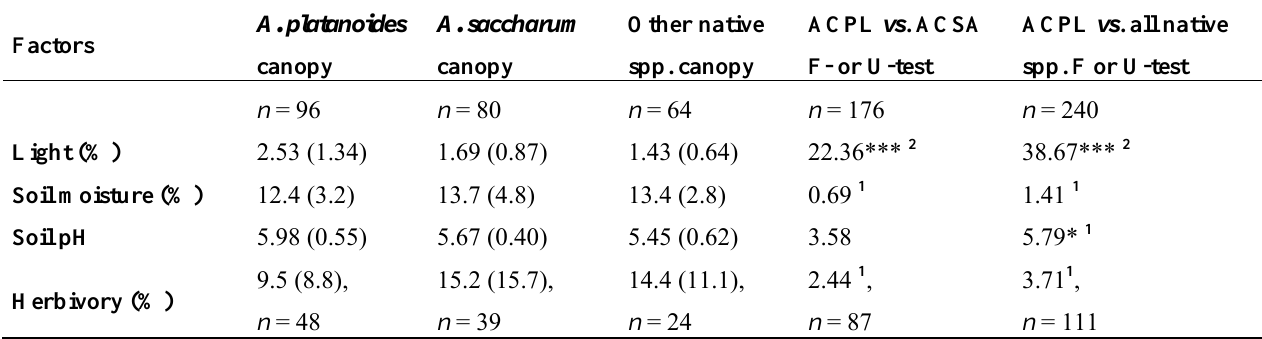
Table 3. Ecological factors measured under A. platanoides , A. saccharum and other native species canopies. Mean values (± SD) are given for each variable, together with test-statistics ( p -values) for the canopy comparisons. was tested on non-harvested seedlings only ( n < n total).